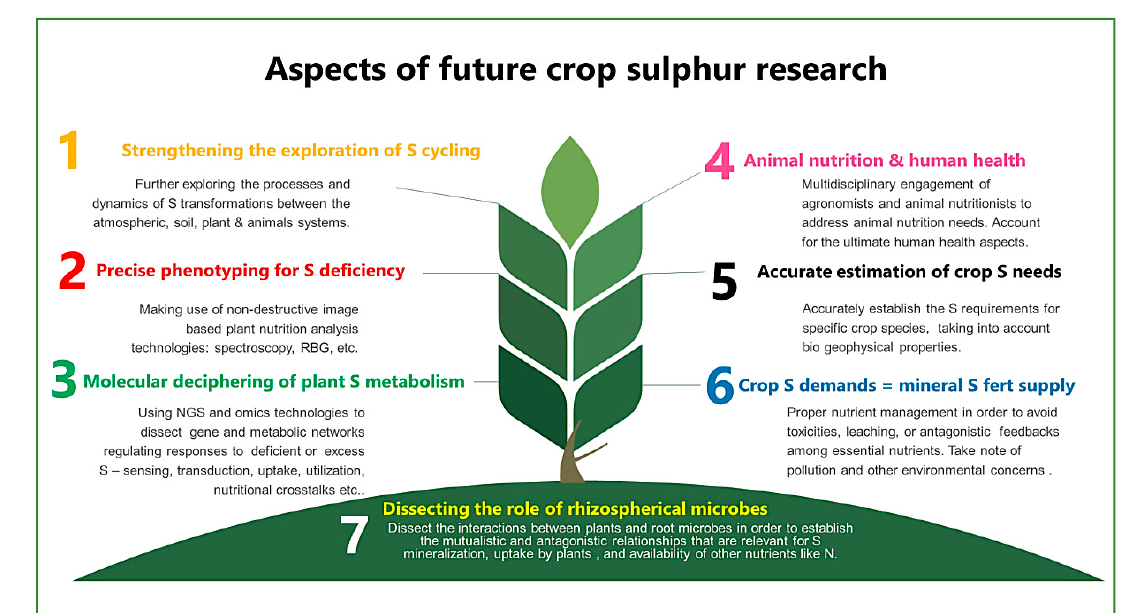
Figure 4. Schematic representation of the key aspects of future crop sulphur research. An integrated multi-disciplinary approach will be needed in S research areas, including accurate plant tissue S estimation, precision phenotyping for nutrients deficiencies, molecular dissection of plant S metabolism, meeting crop S needs, addressing animal nutrition requirements and human quality diet complexities. Note: S, sulphur; NGS, next generation sequencing; RBG, red-blue-green imaging technology.